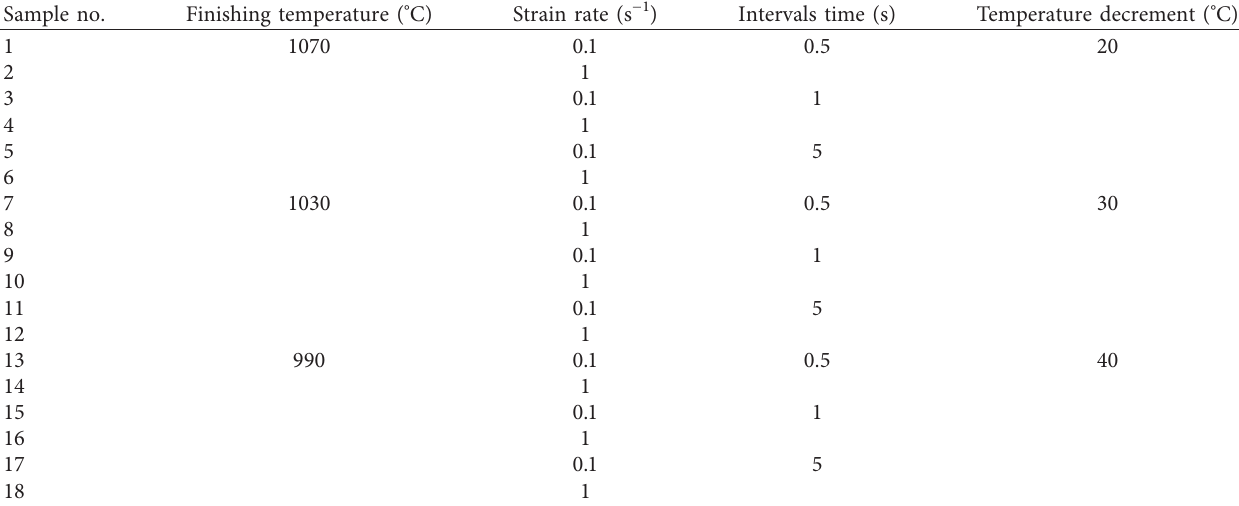
Table 1: Deformation parameters of the nonisothermal multipass compression